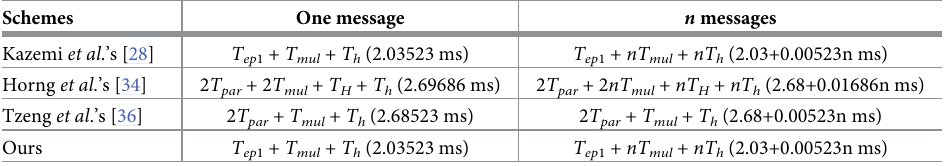
Table 3. Comparison of message verification complexity. Schemes One